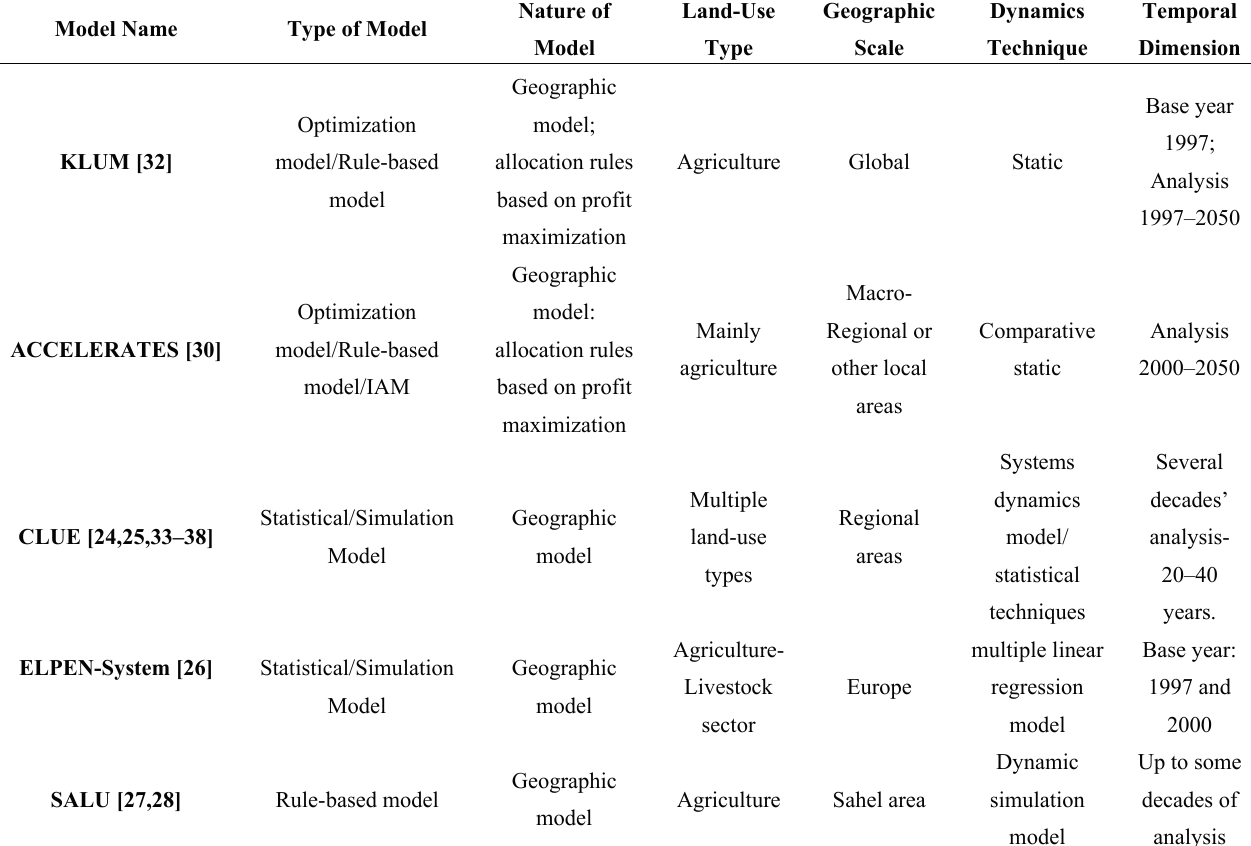
Table 2. General characteristics of some geographic frameworks